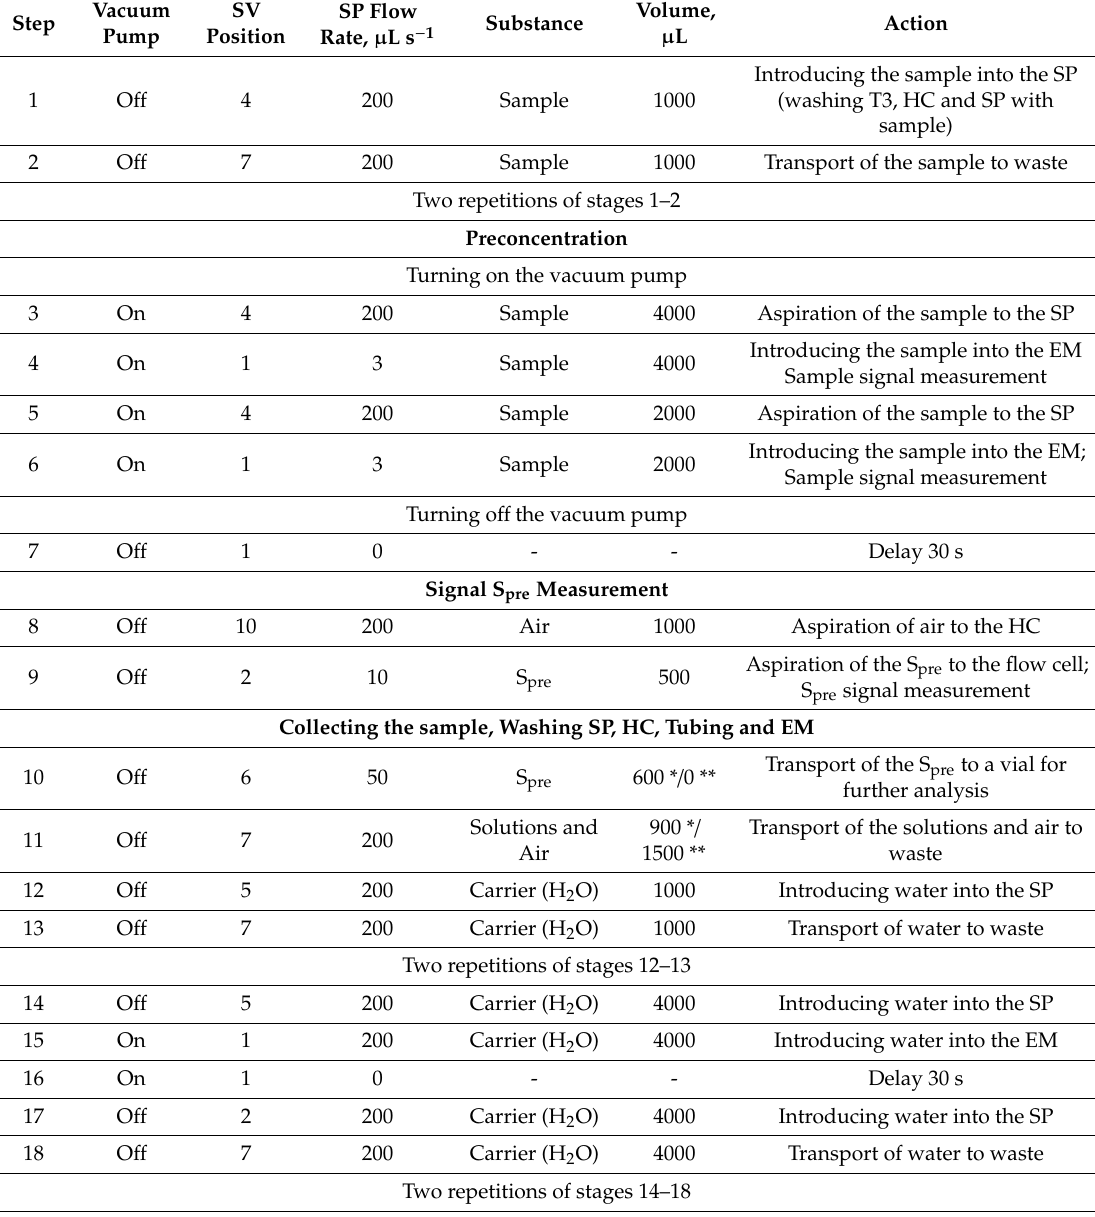
Table 1. Procedure developed for the preconcentration of 6 mL of sample in the proposed flow